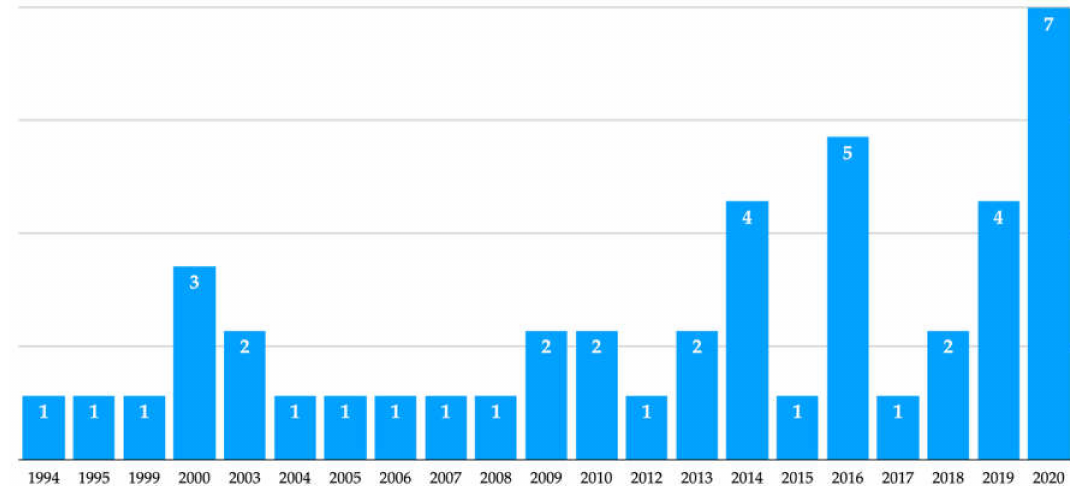
Figure 3. Results by year of the electronic search in